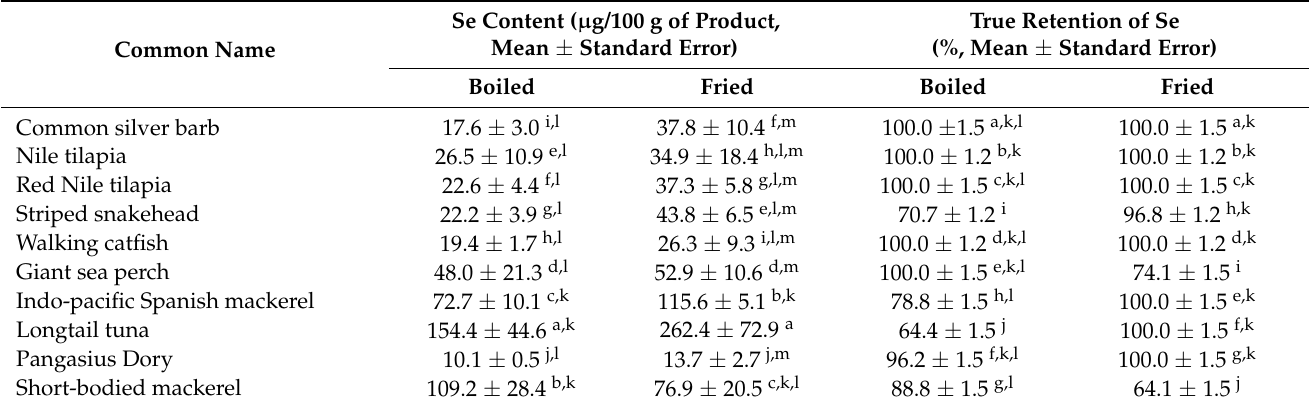
Figure 1. The combined effects of different species of fish and cooking methods on Se concentration ( A ) and on the percentage of true retention ( B ). Table 5. Estimated marginal means of interaction effect of species of fish and cooking methods on Se content and true retention of Se (calculated from two-way ANOVA) ( n = 3).